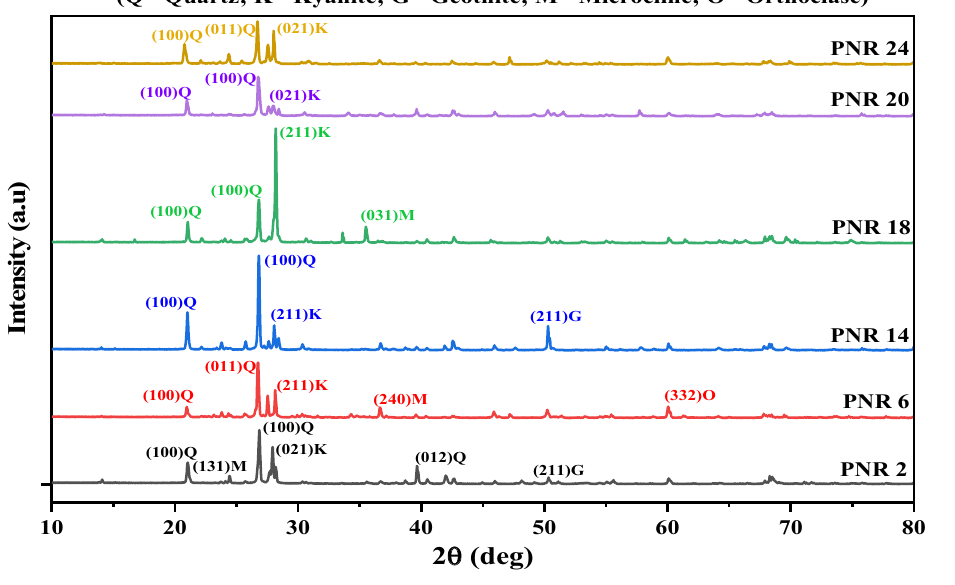
Figure 4. XRD spectrum of river sand samples